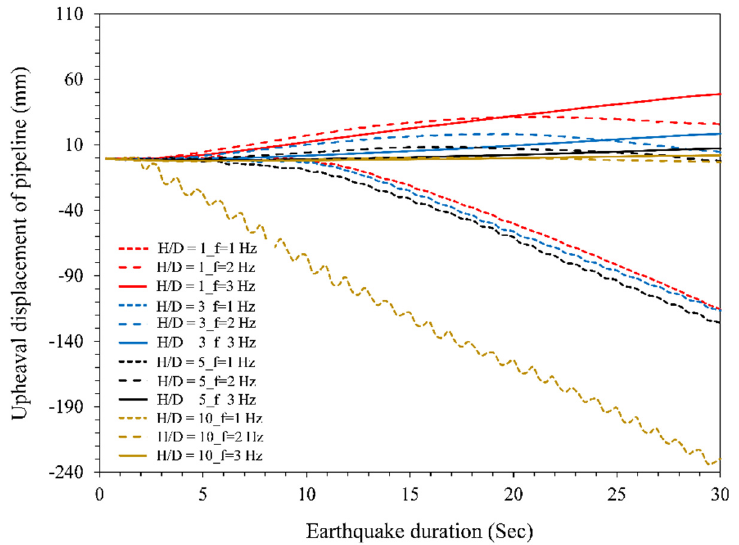
Figure 7. Upheaval displacement of the pipeline buried within a Nevada sand of 50% relative density and under a seismic event with a 0.1 g amplitude.